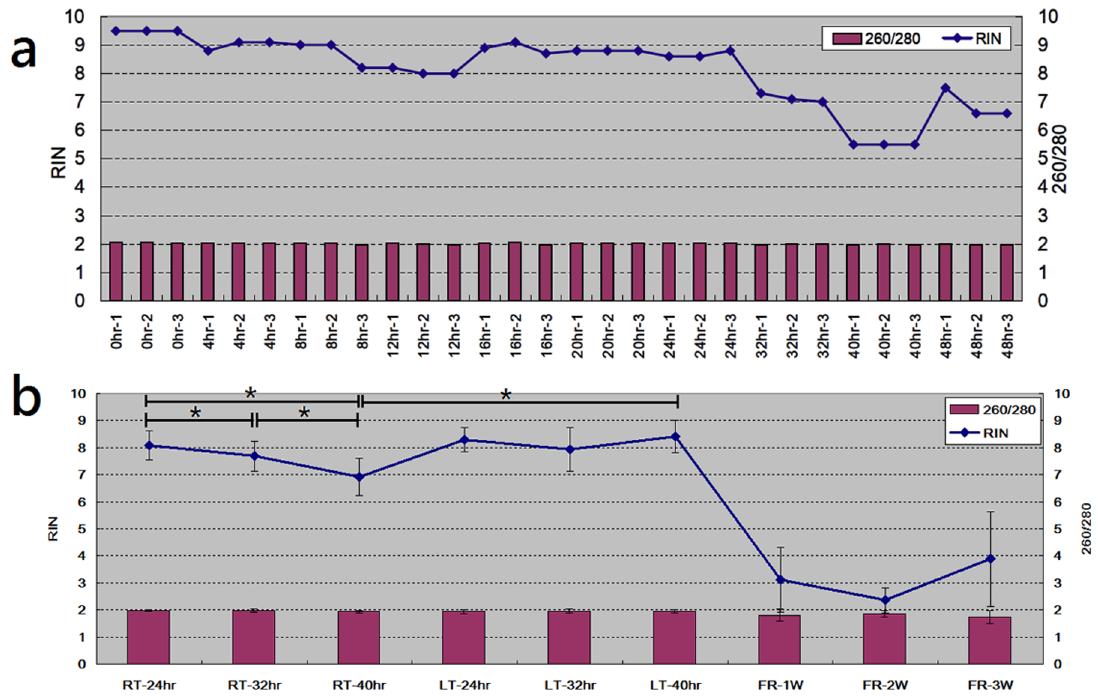
Fig 1. Examinations of RNA quality on samples with different storage temperatures and storage durations. RNA qualitywas evaluatedbased on RIN value measuredwith ABI Bioanalyzer. 260/280value was also determined to exclude contamination. * denotedsignificance by t-test. (a) X axis representeddifferent storage durationsof whole blood.The samples in 0hr set were subject to WBC enrichment and RNA extraction immediately after blood collection.All blood samples were collectedfrom one single subject and the storage temperature is 24˚C. The RIN value curve showeda declineat the duration point of 32hr, demonstrating RNA decayedafter 24hr. (b) RT, LT and FR demonstrated that blood samples were stored at room temperature (24˚C), low temperature (4˚C) and at freezer (-80˚C), respectively. The samplesin FR set were stored at freezer immediately after blood collection.After specifieddurations, they were kept at room temperature for two hours to return to liquidform and to reach up to the balanced24˚C. Consistent with Fig 1A, RNA decayedafter 24hr. Low temperature protectedRNA from degradingat the durationof 40hr. Each subject contributedthree independent blood samples. As a result, for each condition, 30 blood samples were collectedfrom 10 subjects (N = 30). Data was presentedas mean ± SD.All quatitative raw data for plotting each figure and sub-figureis available in S1